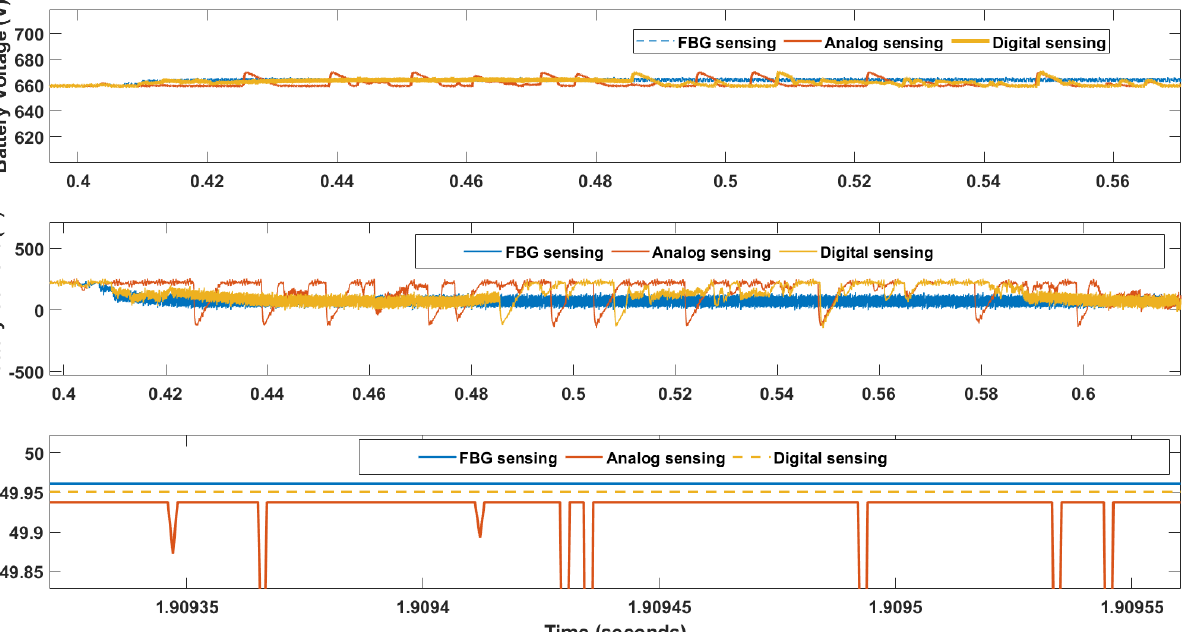
Figure 18. Output metrics at the potential point of PCC output under EMI.